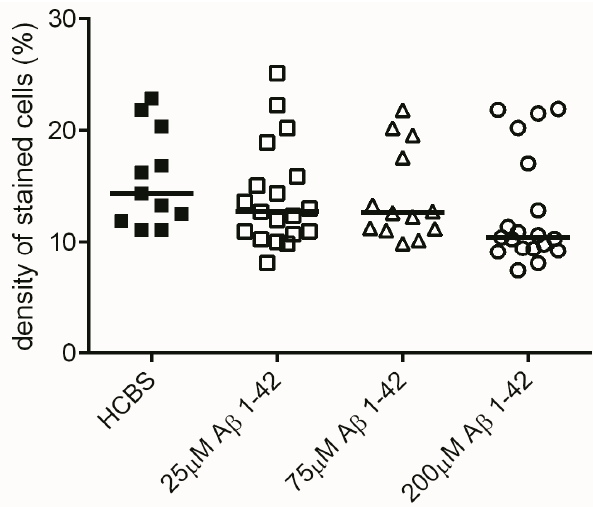
Figure 11. Cresyl violet staining (of hippocampal slices after treatment with different aggregation concentrations (25, 75 and 200 µ M) of A β 1-42 at a 24 h aggregation time. Each dot represents the counted raw data, while horizontal bars indicate median values. No significant difference in staining density, only a clear tendency of decrease was observed among the treatment groups compared to the HCBS group at the 0.05 significance level, n = 4, 2 slices/animal; n refers to the number of animals per group. Statistical significance was determined by the nonparametric independent-samples Kruskal-Wallis test.